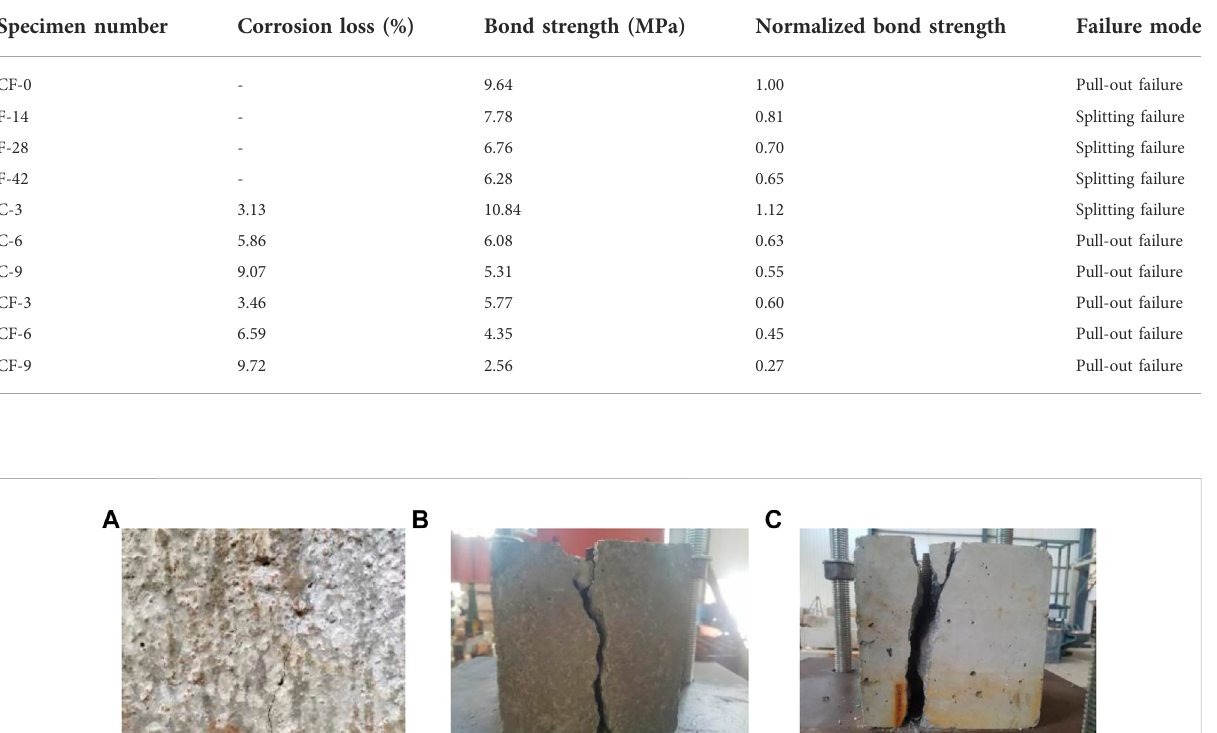
TABLE 3 Pull-out test for different types of steel bar specimens.